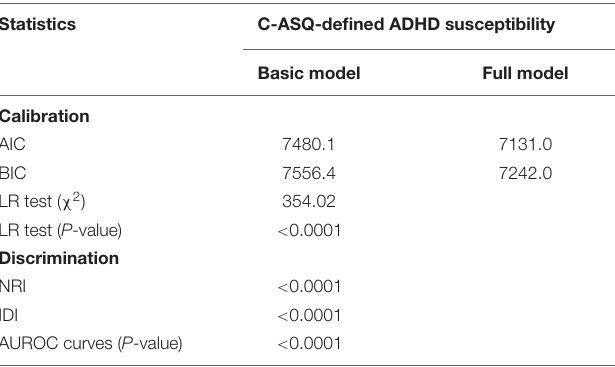
TABLE 3 | Prediction accuracy gained by adding five significant factors associated with C-ASQ-defined ADHD susceptibility in pre-school